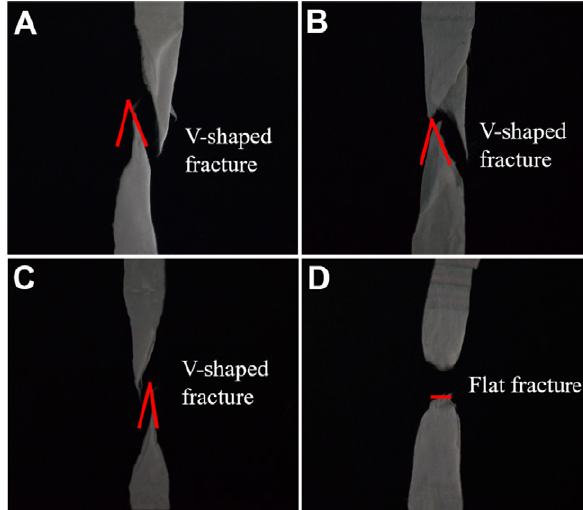
Figure 10: Fracture morphology of PAN nanofiber membranes with different concentrations: A) 8wt%; B) 10wt%; C) 12wt%; D) 14wt%.